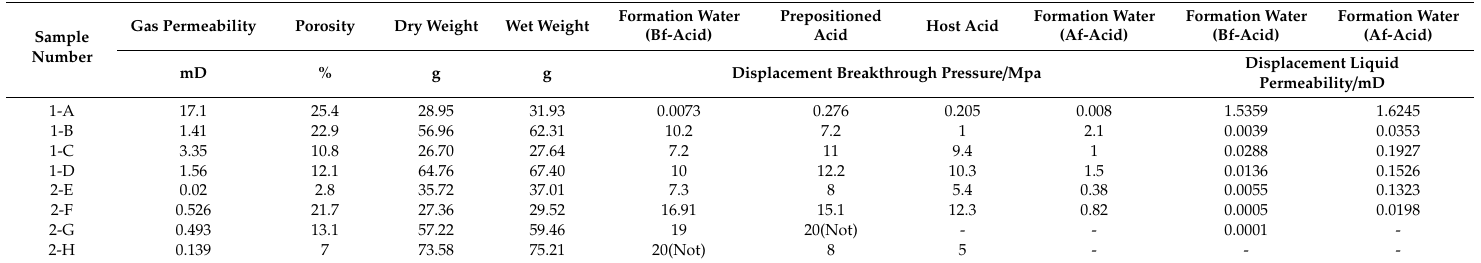
Table 2. Core acidification experimental results of the selected mixed siliciclastic-carbonate